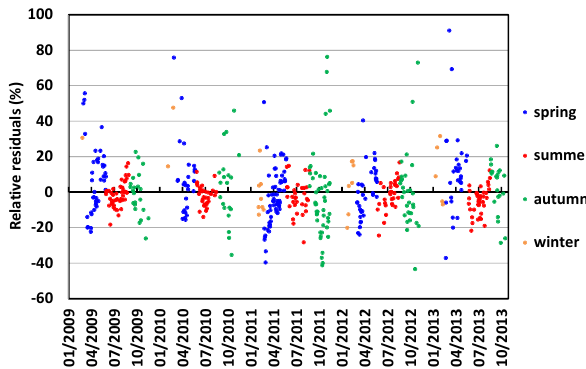
Figure 10. Relative residuals (=(measured − modeled) / measured × 100) of the seasonal multiple regression models. The colors rep- Fig. 10. Relative residuals (=(measured-modeled)/measured*100) of the seasonal multiple resent the different seasons: blue – spring; red – summer; green – regression models. The colors represent the different seasons: blue=spring; red=summer; autumn; and orange – winter. green=autumn; orange=winter.